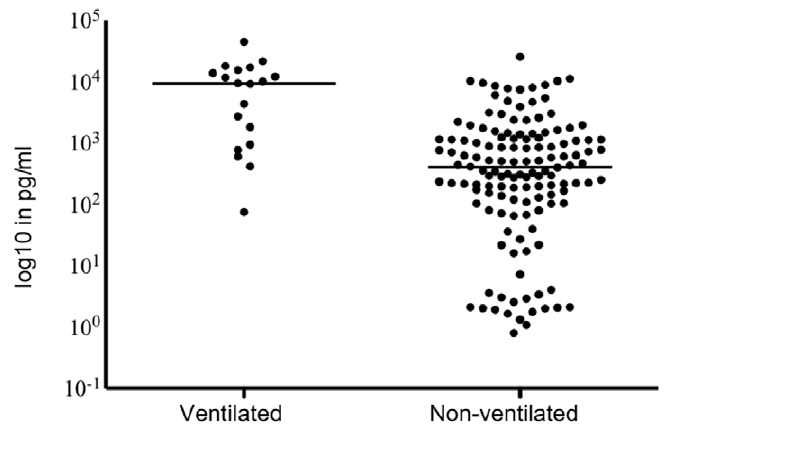
Figure 1. Median concentrations of IL1RL1-a in nasopharyngeal aspirates of hospitalized infants with RSV were . 20-fold higher in mechanically ventilated infants at the Pediatric Intensive Care Unit (n=19) when compared to non-ventilated infants admitted to the general pediatric ward (n=135) (median [and quartiles] 9,357 [936–15,528] pg/ml vs 405 [112–1,193] pg/ml respectively; Mann- Whitney U test p ,